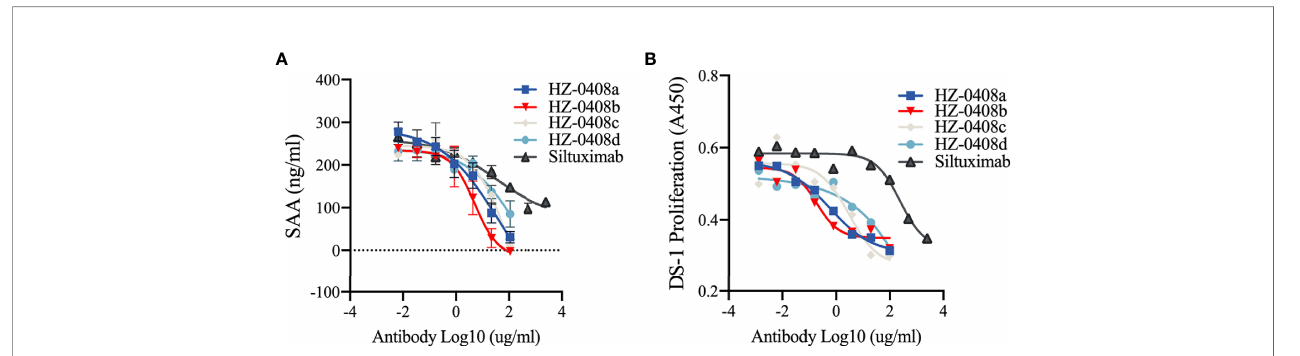
FIGURE 2 | The humanized anti-IL-6 mAbs are effective on inhibiting IL-6 induced SAA secretion and IL-6 dependent cell proliferation. (A) The humanized anti-IL-6 mAbs and Siltuximab inhibited the induction of SAA expression by IL-6 and IL-1 b in an does-dependent manner in HepG2 cells. HepG2 cells (2X10 5 ) were plated in 48-well plate and incubated with serially diluted humanized anti-IL-6 mAbs or Siltuximab in the presence of 100 ng/ml IL-6, 200 ng/ml IL-6R, and 25 ng/ml IL-1 for 48 hr. Supernatant was collected for ELISA. (B) In vitro growth-inhibitory effect of the humanized anti-IL-6 mAbs and Siltuximab in IL-6-driven expansion of DS-1 cells. DS-1 cells (8×104/mL) were incubated with 20 ng/ml IL-6 in the presence of serially diluted humanized anti-IL-6 mAbs or Siltuximab for 72 hr. Cell counting kit-8 (CCK8) was used to measure the cell proliferation, and absorbance at 450nm are